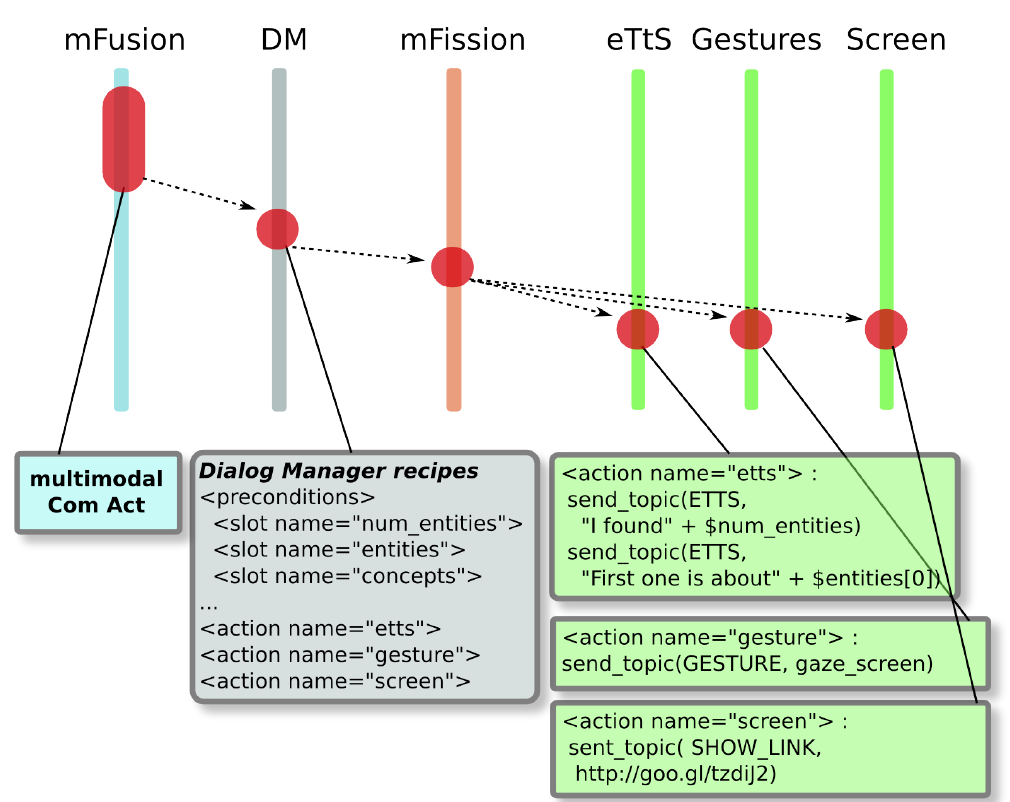
Figure 10. Information flow from multimodal fusion to multimodal